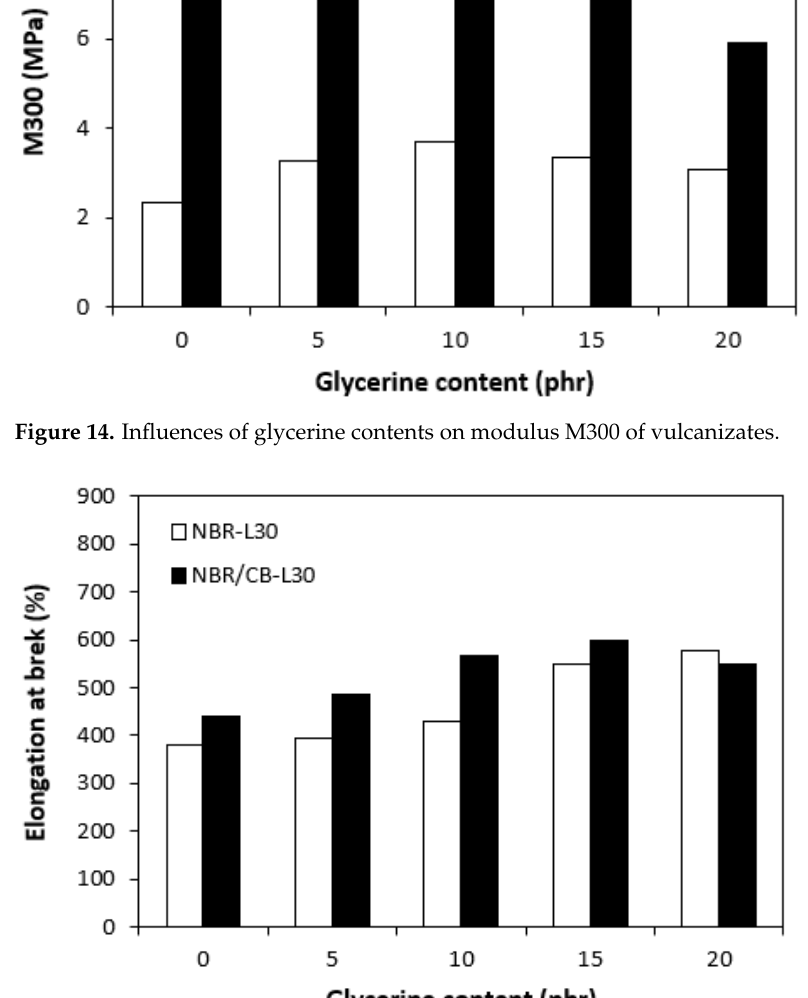
Figure 15. Influences of glycerine contents on elongation at breaks of vulcanizates.